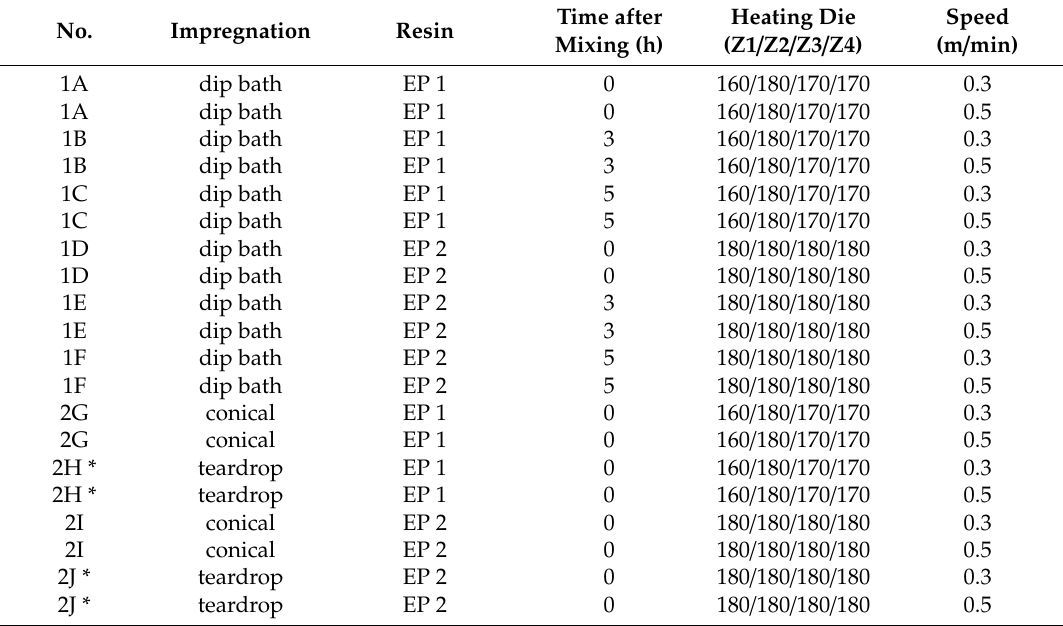
Table 2. Design of experiments: used resin, mixing time and impregnation method.